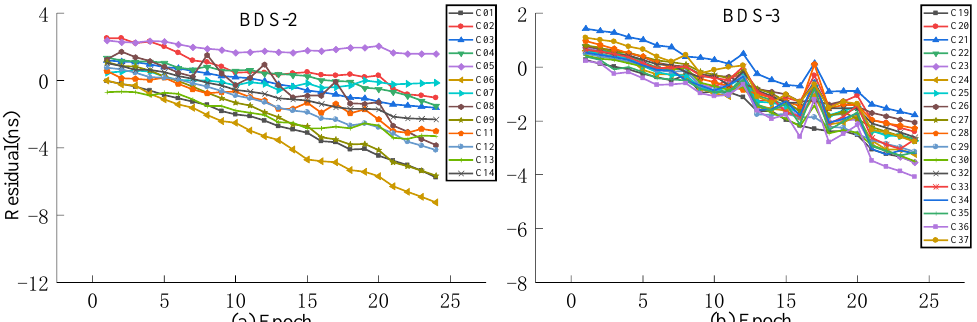
Figure 13. The residual plot of the ISUP model using the 6th hour update ultra-fast clock product of the day. ( a ) The residual value of BDS-2 predicted after 6 h. ( b ) The residual value of BDS-3 predicted after 6 h.